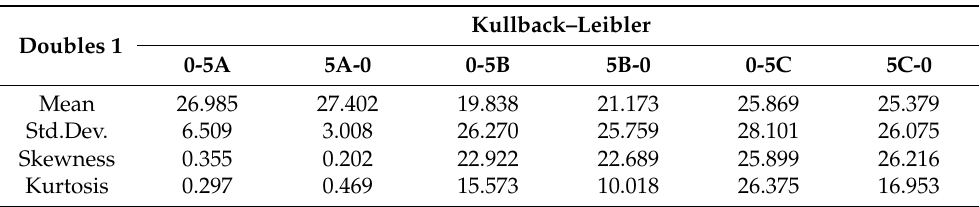
Figure 19. Comparison of the probability distributions obtained for the mean values of the doubles sensor 1 measurements in the case of failures associated with the doubles sensors. Indicators: ( top left ) mean, ( top right ) standard deviation, ( bottom left ) skewness and ( bottom right ) kurtosis. Table 6. Kullback–Leibler divergence values associated with the means, standard deviations, skew- ness and kurtosis associated with the mean values of the double 1 sensor measurements for the identification of the failures associated with the double sensors.